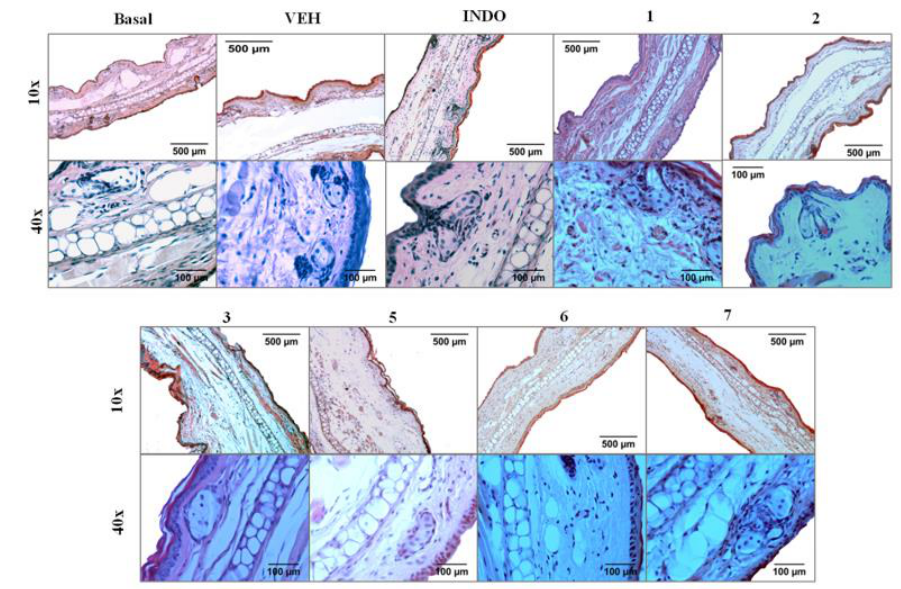
Figure 5. Representative pictures of histological transversal cuts of mice ears and analysis of alterations induced by TPA and effect different kinds of compounds isolated from B. conferta from mice ears stained with hematoxylin-eosin. Schensianol A ( 1 ), bacchofertin ( 2 ), kingidiol ( 3 ), bacchofertone ( 5 ), hispidulin ( 6 ) and cirsimaritin ( 7 ).